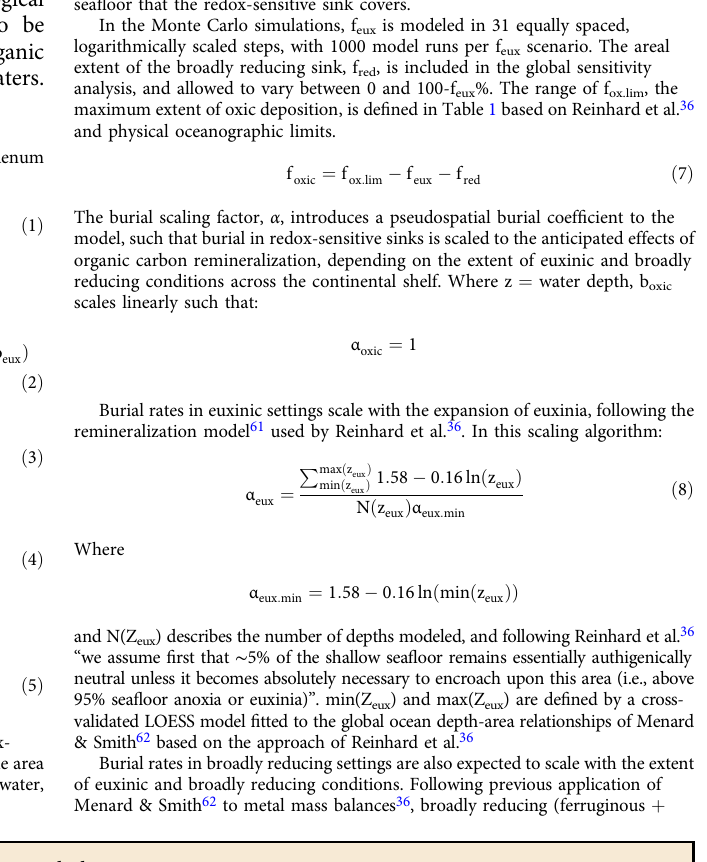
Table 1 Minimum and maximum values included in metal mass balances.